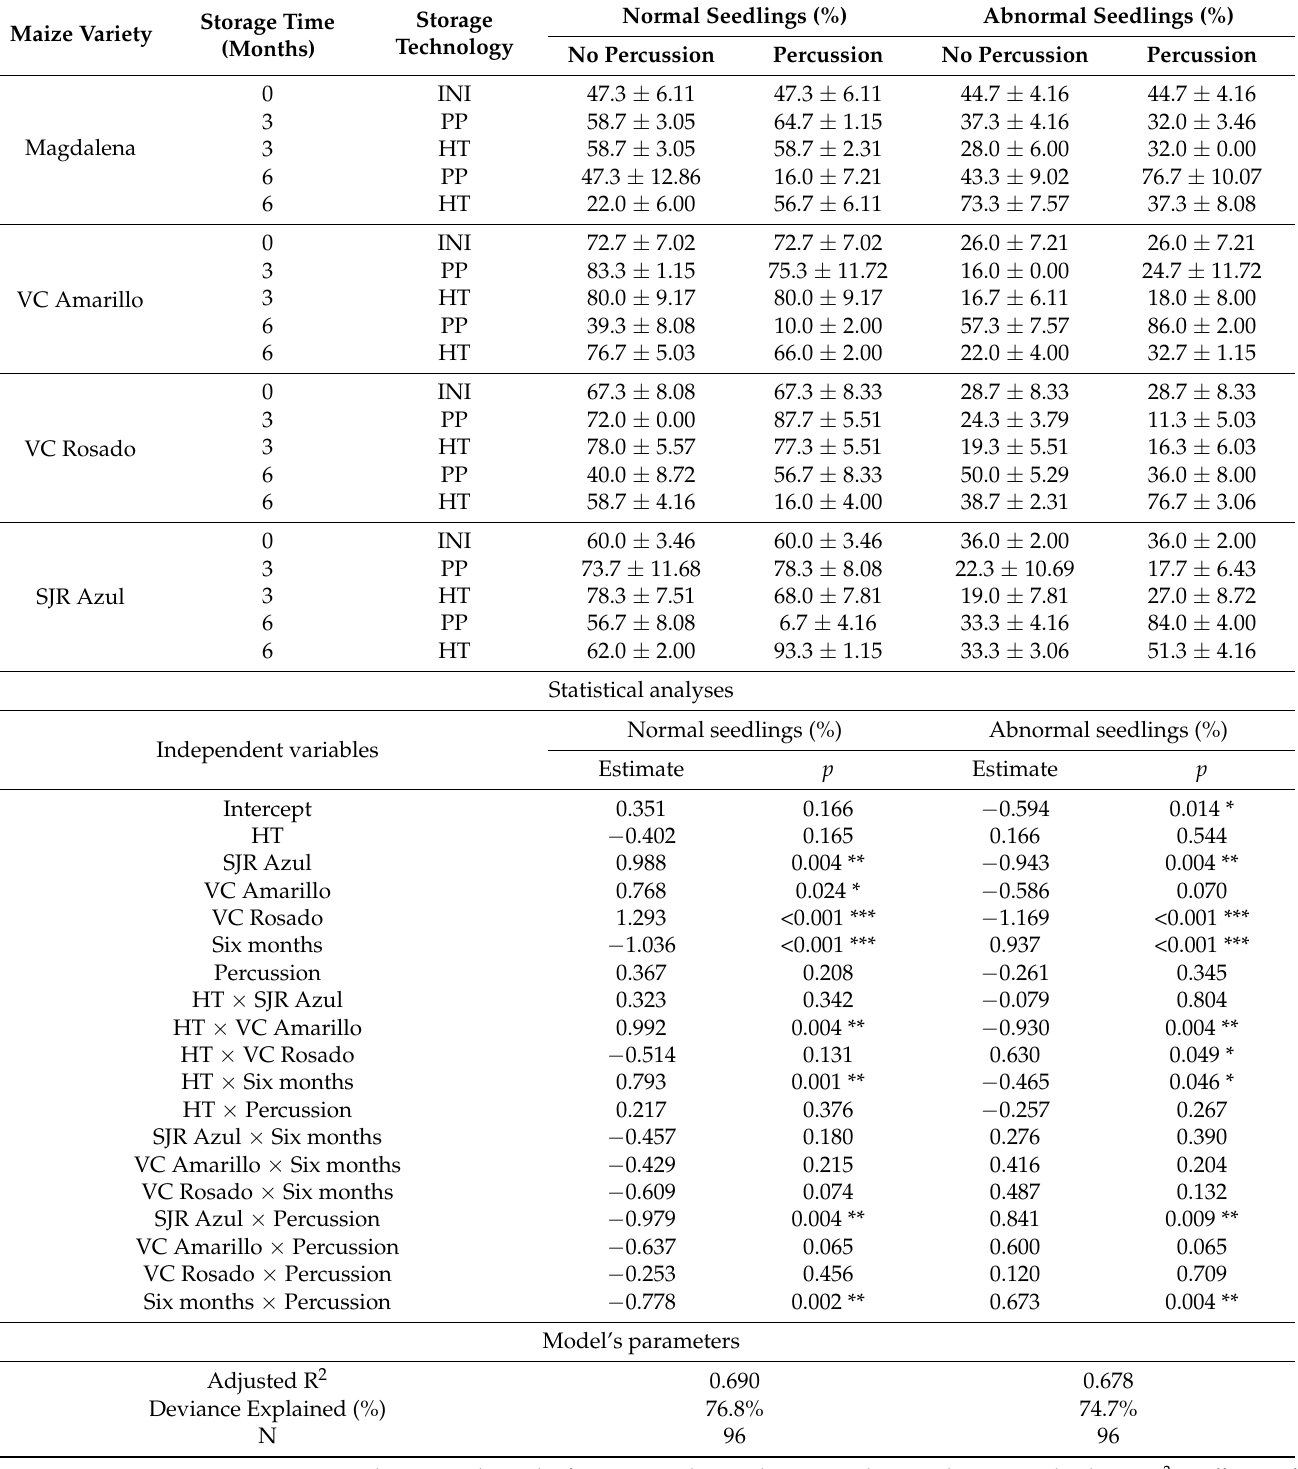
Table 3. Average percentages ( ± standard deviation) of normal seedlings and abnormal seedlings, after 3 and 6 months of storage with germination assays performed 1 day after opening